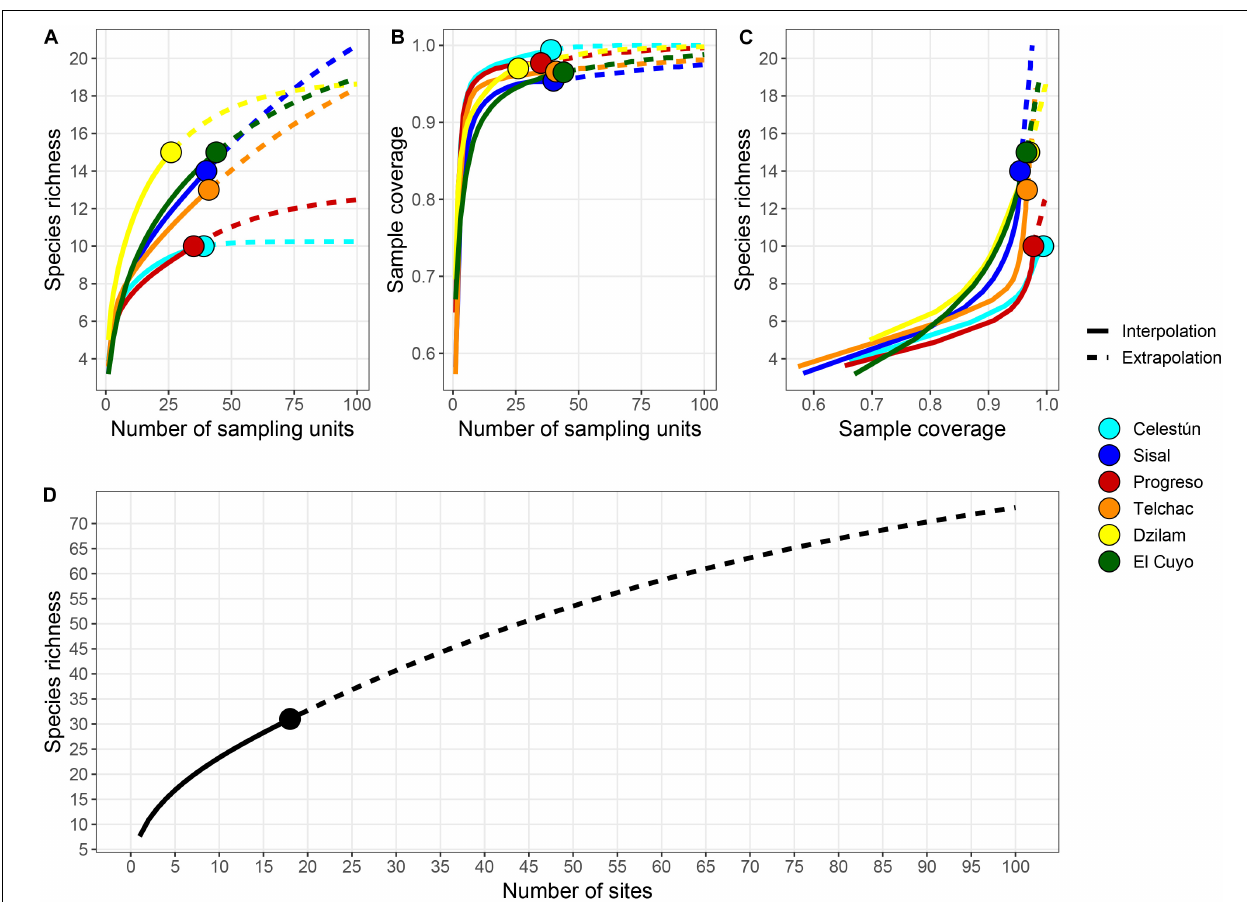
FIGURE 5 | Interpolation and extrapolation of richness values and sample completeness analyses of sandy beaches of Yucatán. (A) Species accumulation curve based on the incidence of species for each locality. (B) Sample-coverage accumulation curve based on incidence for each locality. (C) Sample completeness curves linking curves in panels (A,B) . (D) Species accumulation curve for the coast of Yucatán based on the incidence of species in 18 sampled sites. The solid lines represent interpolation, while dashed lines extrapolation. Solid circle represents the observed